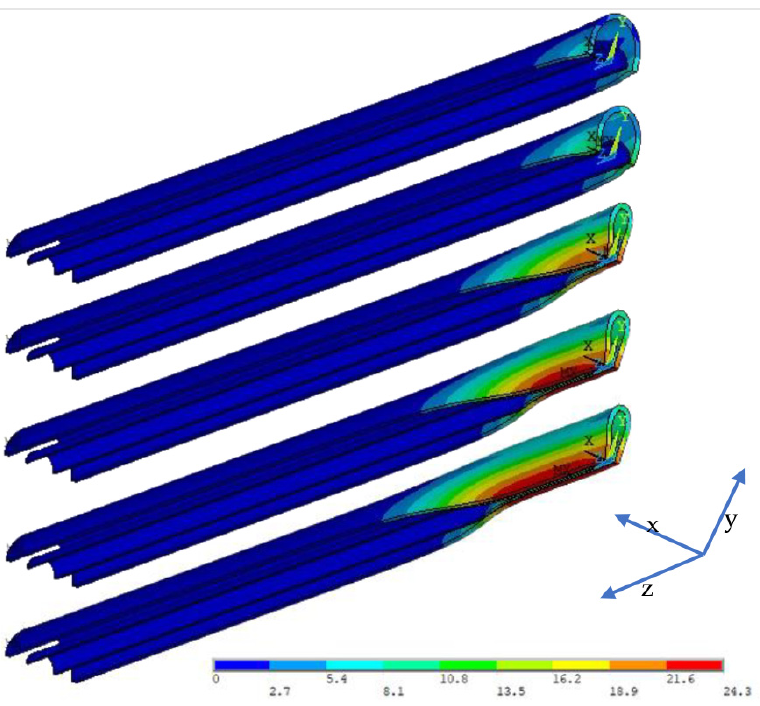
Figure 5. Deformation of PIP system during buckle propagation of Case N40 (unit: mm).